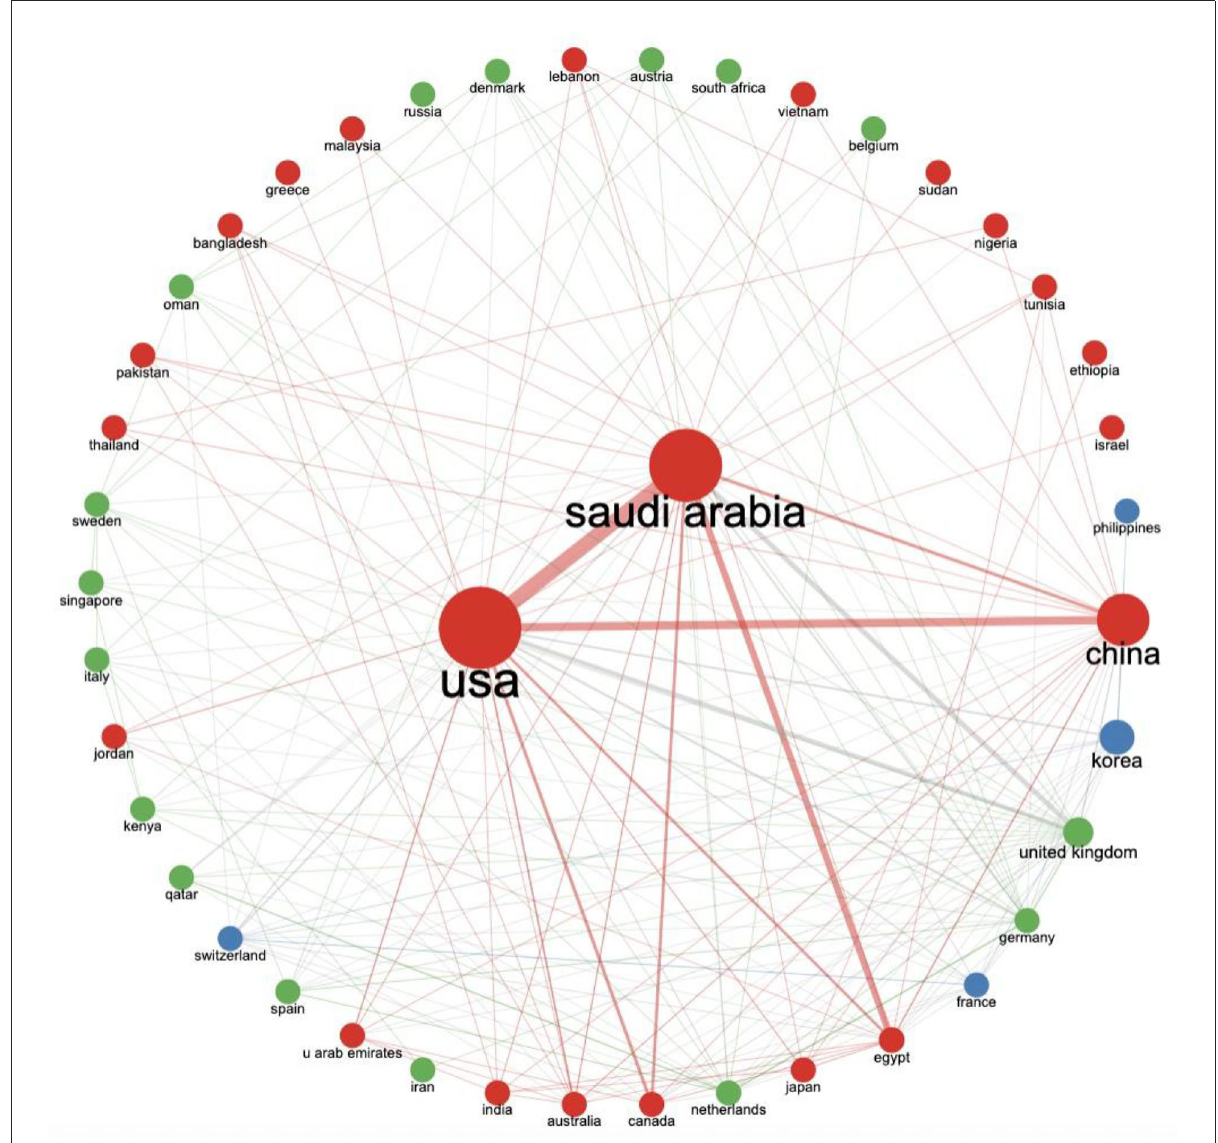
FIGURE6 Inter-countries or regions collaboration. The thicker the line between two countries or regions, the stronger the collaboration, while the bigger the node, the higher the contribution (publications).